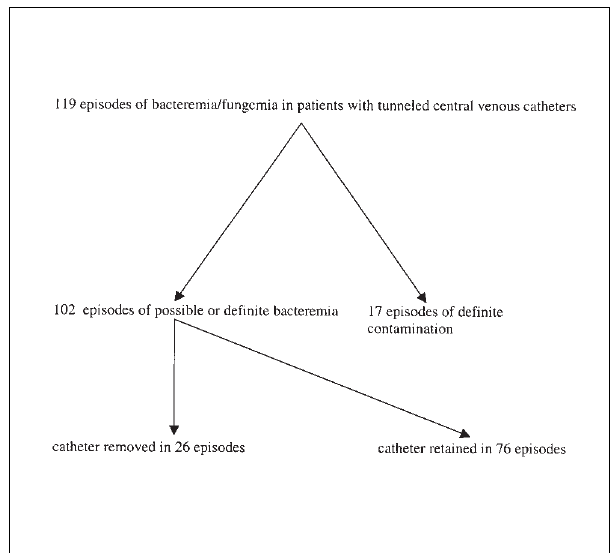
Figure 1) Outcome of 119 episodes of bacteremia in paediatric oncol- ogy patients with central venous tunnelled catheters (another two episodes occurred in patients without a central venous tunnelled catheter). Four episodes occurred in patients with implanted ports and 117 episodes in patients with Broviacs (CR Bard Inc, USA). All the catheters that were removed were Broviacs except one implanted port in a patient with